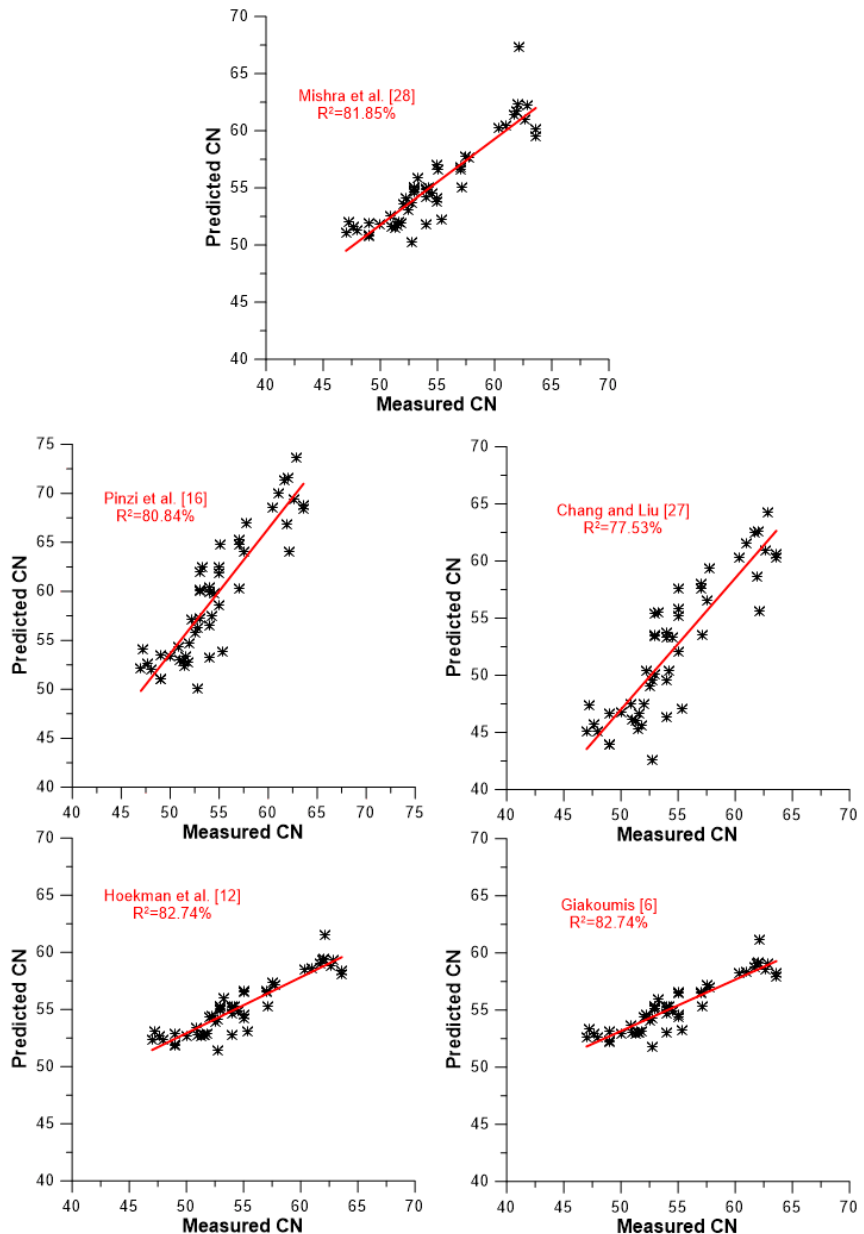
Figure 8. Comparison of predicted (equations from Section 3.2) vs. experimental CN values for the five models based on the average biodiesel degree of unsaturation and chain length (experimental data from the third column of Table 5).